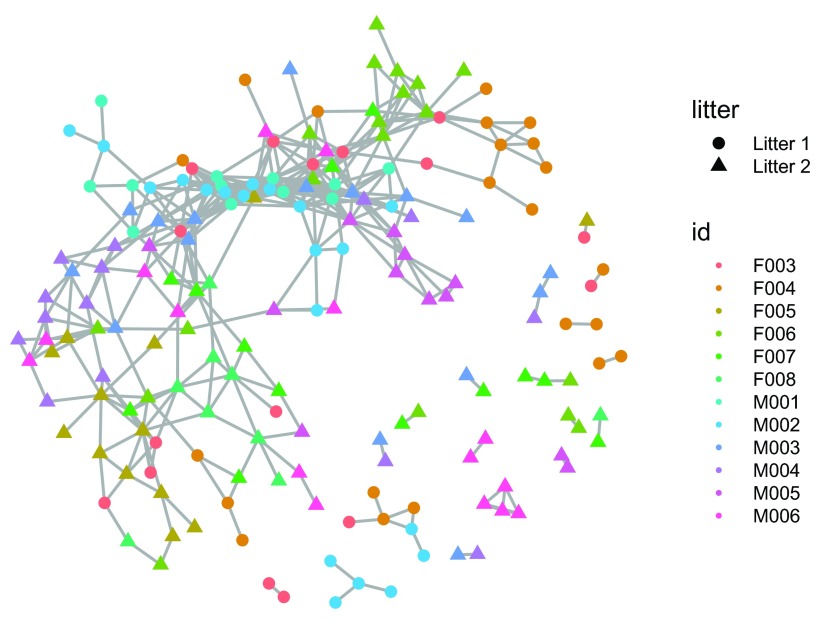
A network created by thresholding the Jaccard dissimilarity matrix.The colors represent which mouse the sample came from and the shape represents which litter the mouse was in.